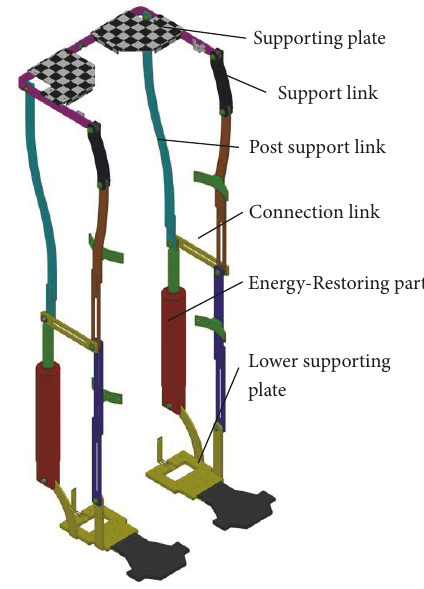
Figure 1: CAD model of the proposed unpowered